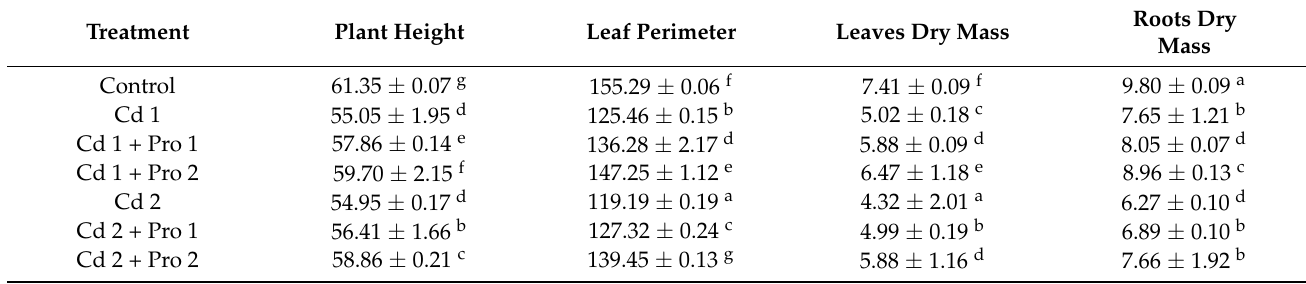
Values represent the means of three replicates ± SD. Cd 1 (4 mg), Cd 2 (8 mg), Cd 1 + Pro 1 (4 mg Cd + 3 mM proline), Cd 1 + Pro 2 (4 mg Cd + 6 mM proline), Cd 2 + pro 1 (8 mg Cd + 3 mM proline), Cd 2 + Pro 2 (8 mg Cd + 6 mM proline). Different small letters in columns show significant differences and same small letters show non-significant differences ( p ≤ 0.05) according to Duncan’s multiple range